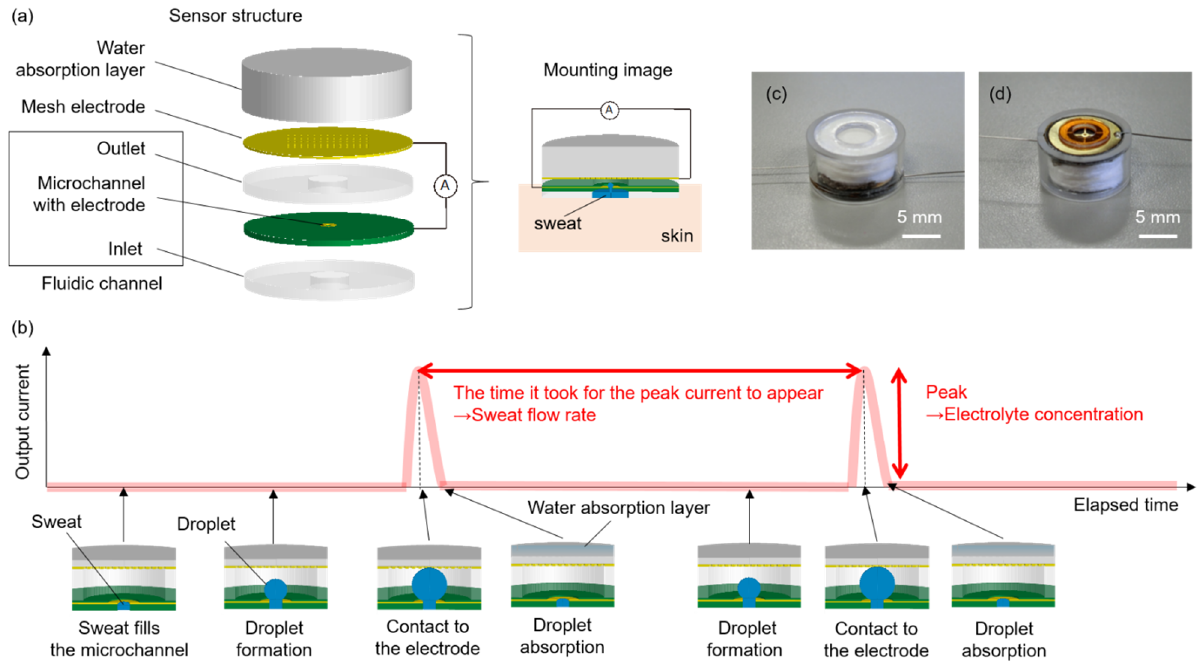
Figure 1. ( a ) Schematic illustration of the sensor mounted on skin. ( b ) Sensing protocol for sweat flow rate and electrolyte concentration monitoring. The graph schematically shows the time-dependent fluctuation of the output current obtained from the sensor output along with illustrations of droplet formation in the sensor chamber corresponding to the changes in output currents. ( c ) Fabricated sensor (top view). ( d ) Fabricated sensor (bottom